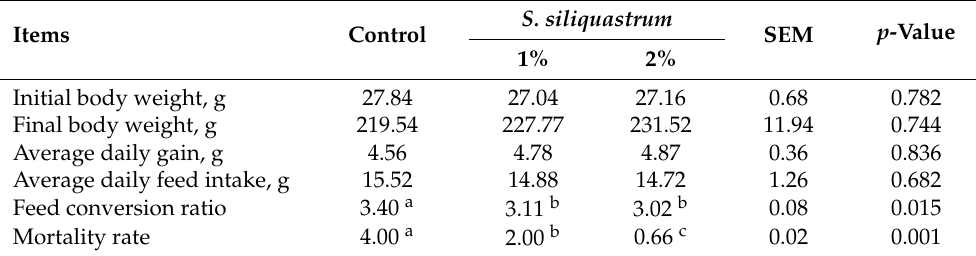
Table 3. Effects of S. siliquastrum dietary treatment on growth performance in Japanese